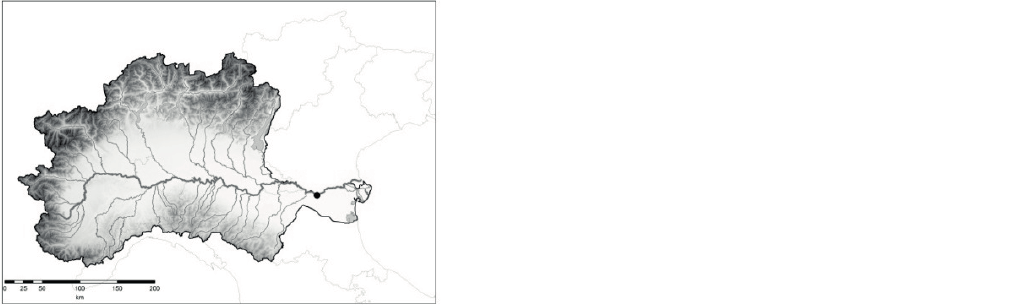
Fig. 1 Po River and its main tributaries; the dot indicates the river closure section of Pontelagoscuro.